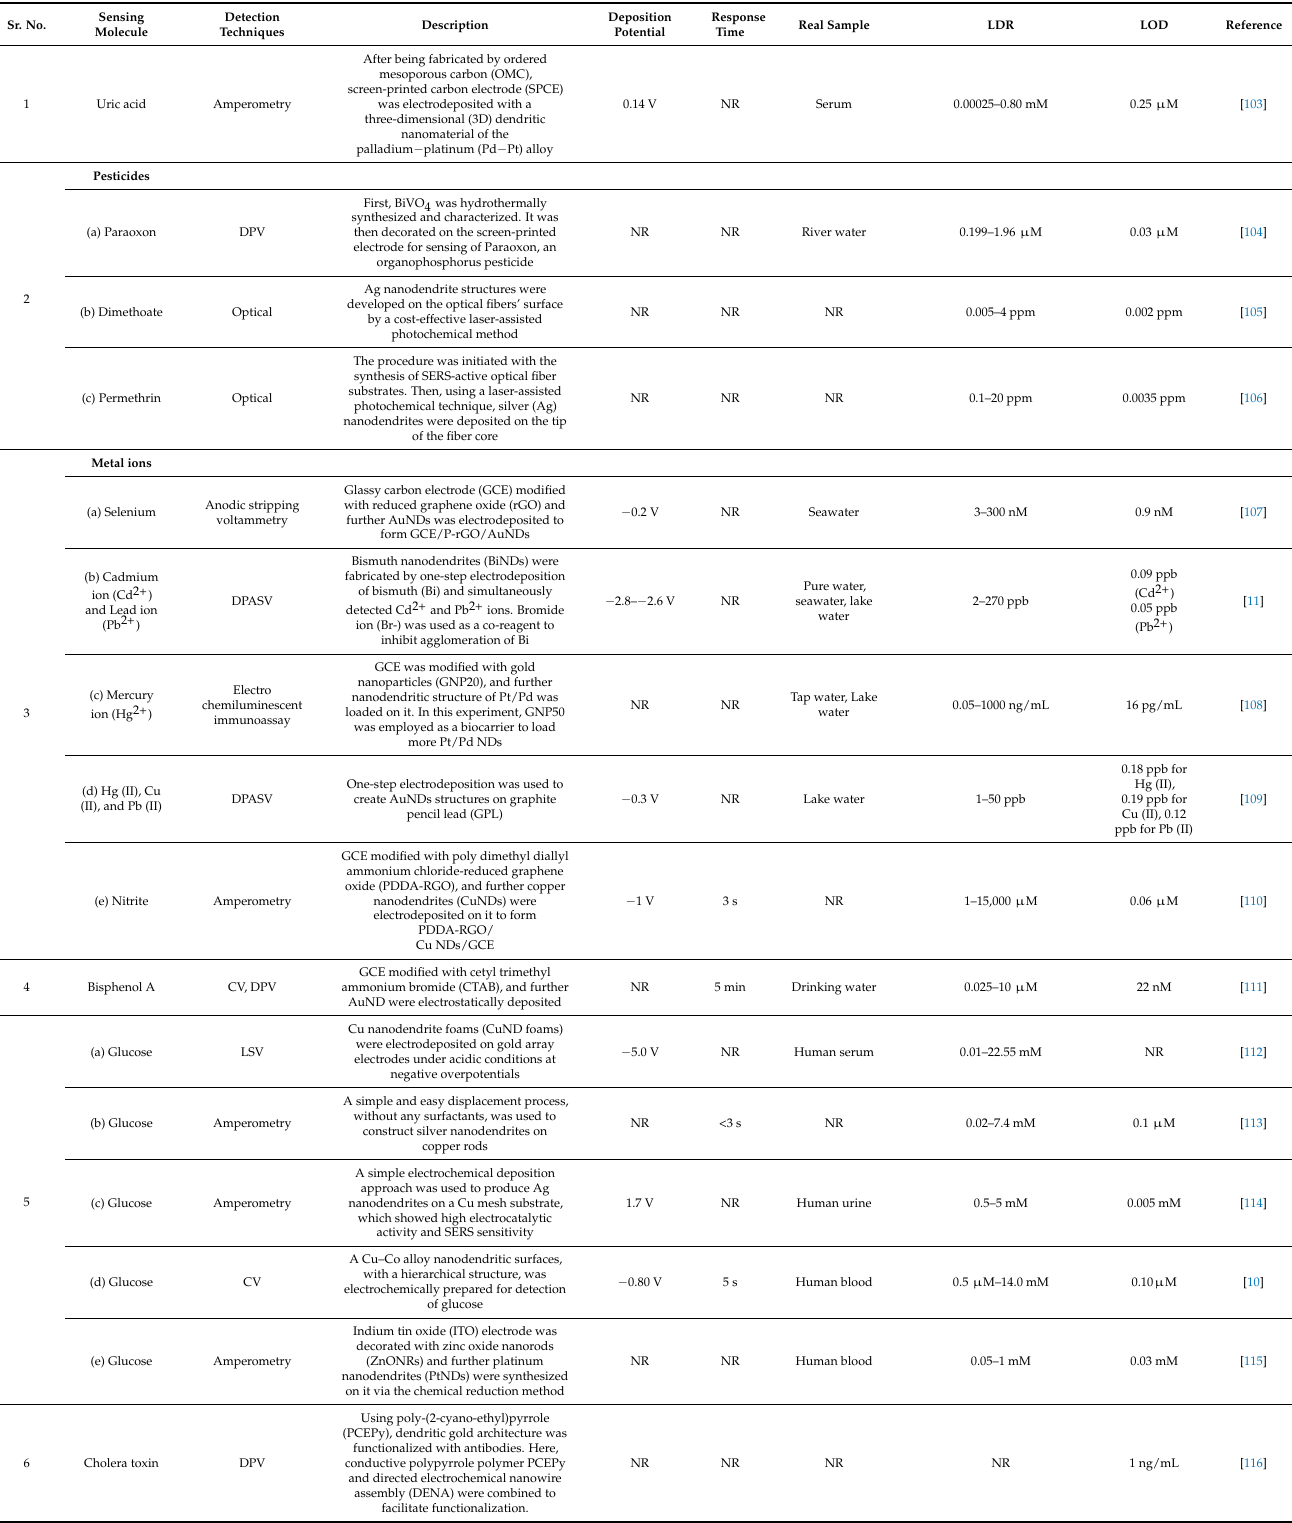
Table 1. Various metallic nanodendrites-based biosensors for sensing of small molecules. (NR—not